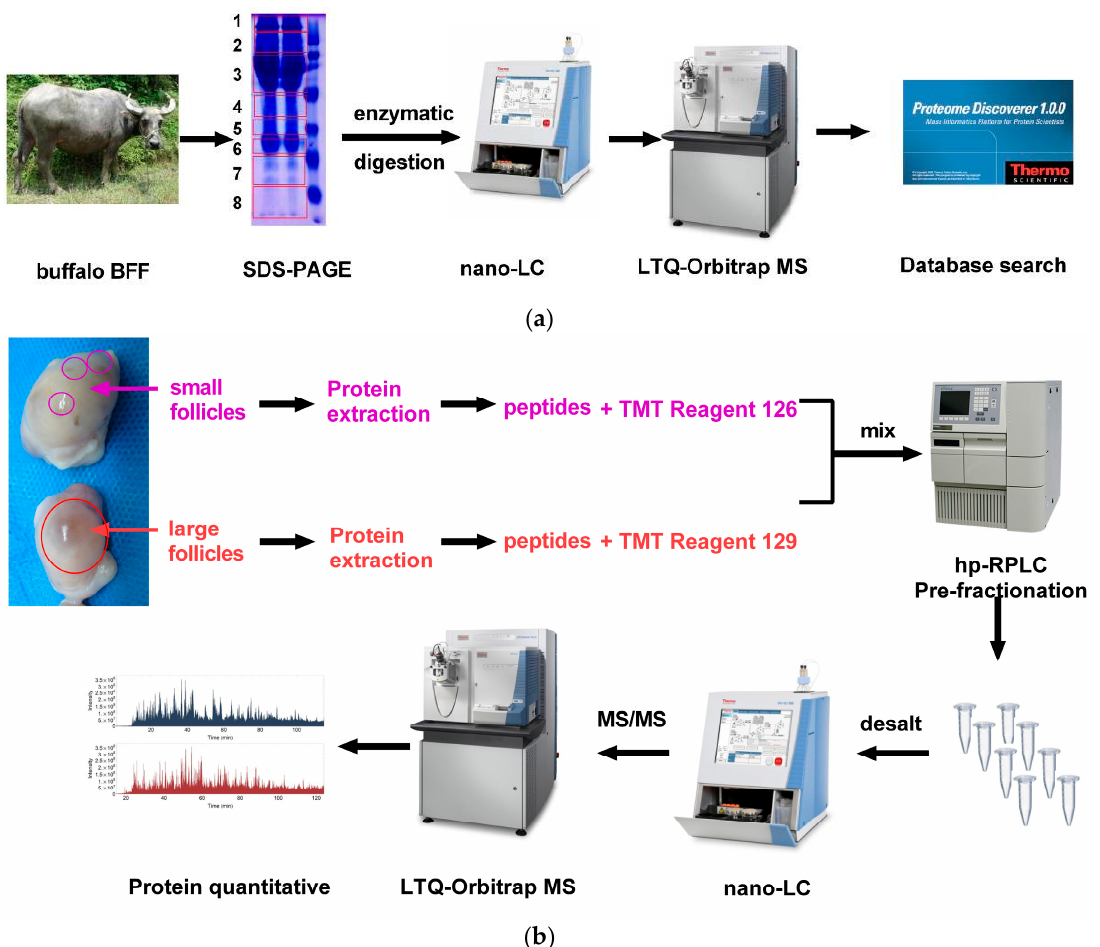
Figure 8. Schematic of proteomic analysis of buffalo follicular fluid (BFF): ( a ) proteomic workflow of BFF protein profile;and ( b ) comparative proteomics workflow for large and small follicles.